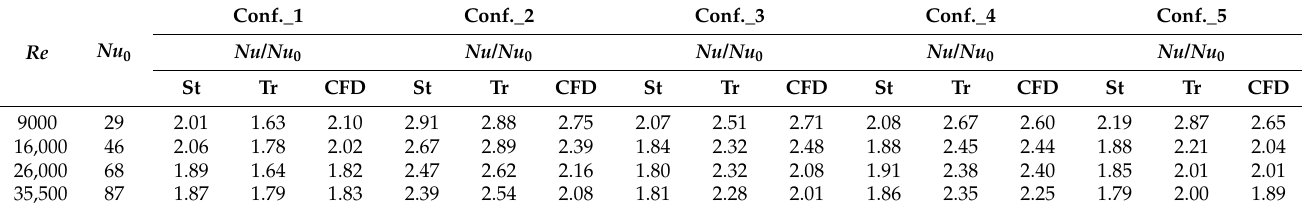
Figure 21. Local Nusselt number distribution for different Re numbers for a channel with ribs slanted at 90° to each other (configuration_5). Table 2. Comparison of the Nusselt number determined by three methods: steady state, transient method and CFD for P/e = 11 (section p4).